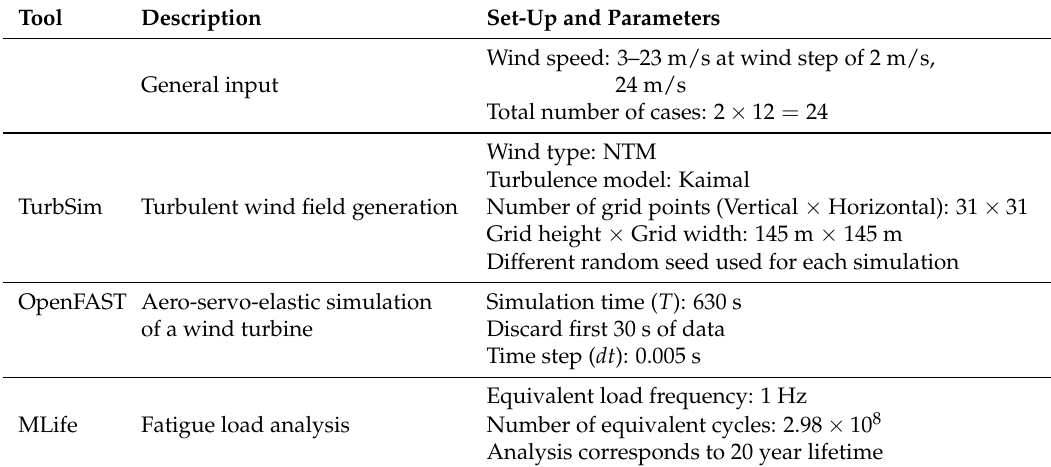
Table 2. Details of the simulations for the fatigue load